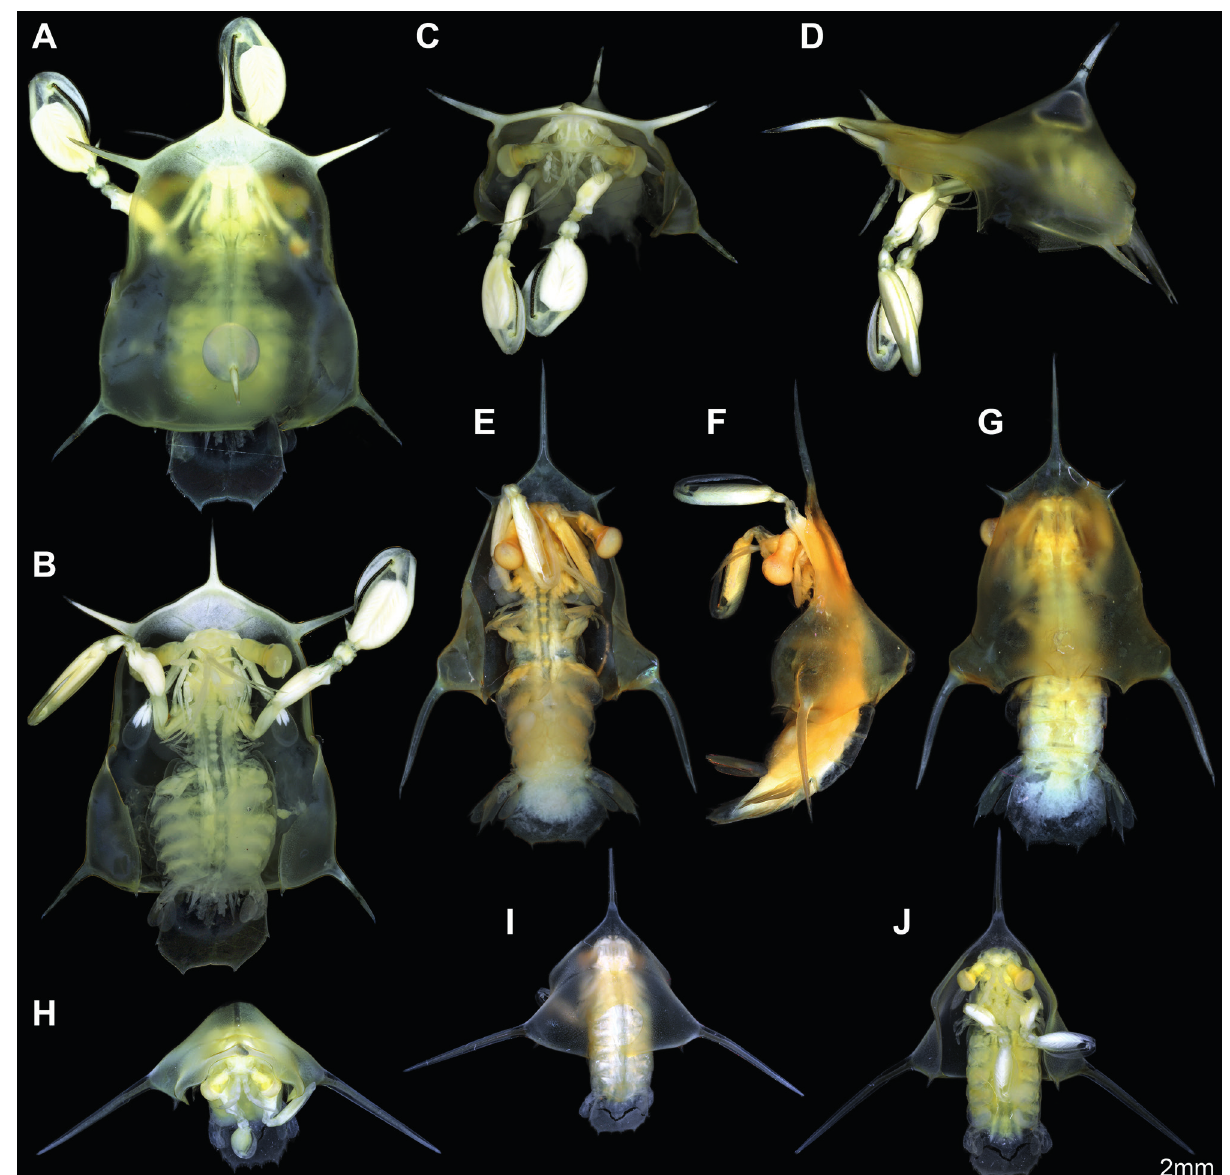
Figure 8. Different erichthus-type larvae demonstrating the morphological diversity. A–D. ZMUC-CRU-8667. A. Dorsal view. B. Ventral view. C. Antero-ventral view. D. Lateral view. C, D flipped horizontally. E–G. ZMUC-CRU-8668. E. Ventral view. F. Lateral view. G. Dorsal view. H–J. ZMUC-CRU-8664. H. Anterior view. I. Postero-dorsal view. J. Ventral